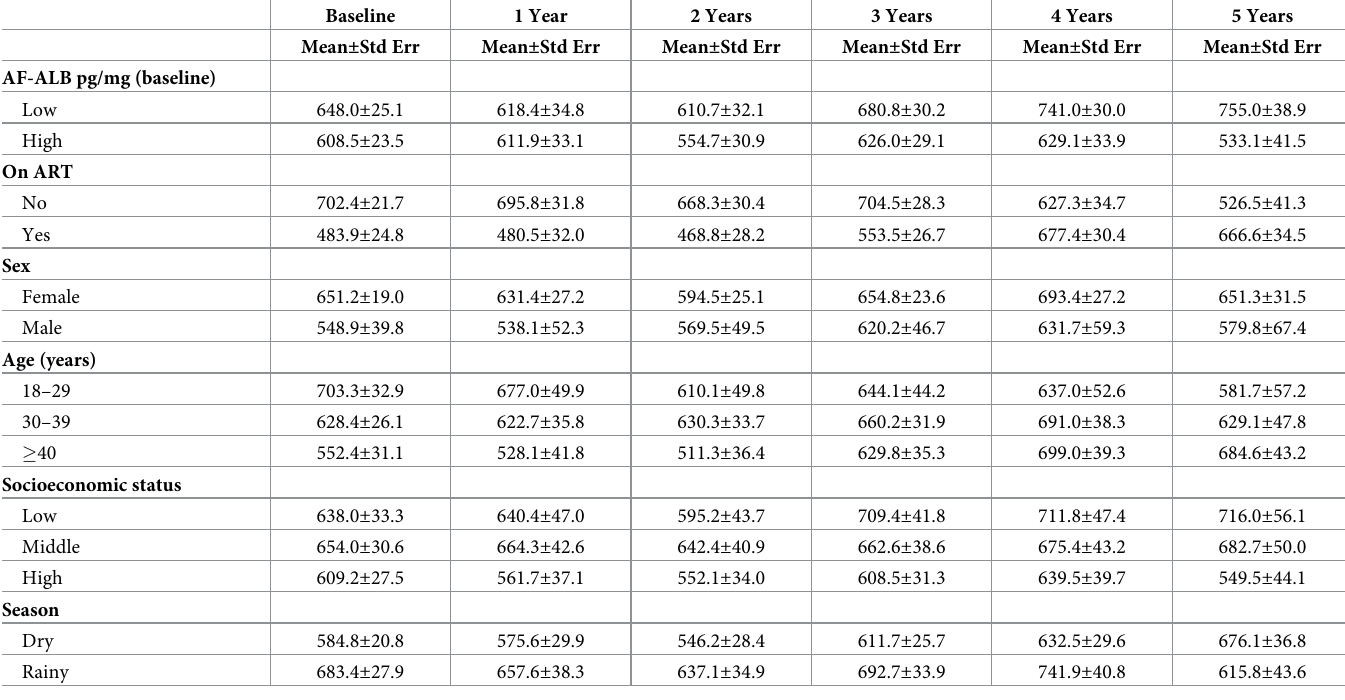
Table 2. Unadjusted mean estimates for CD4 count over the study